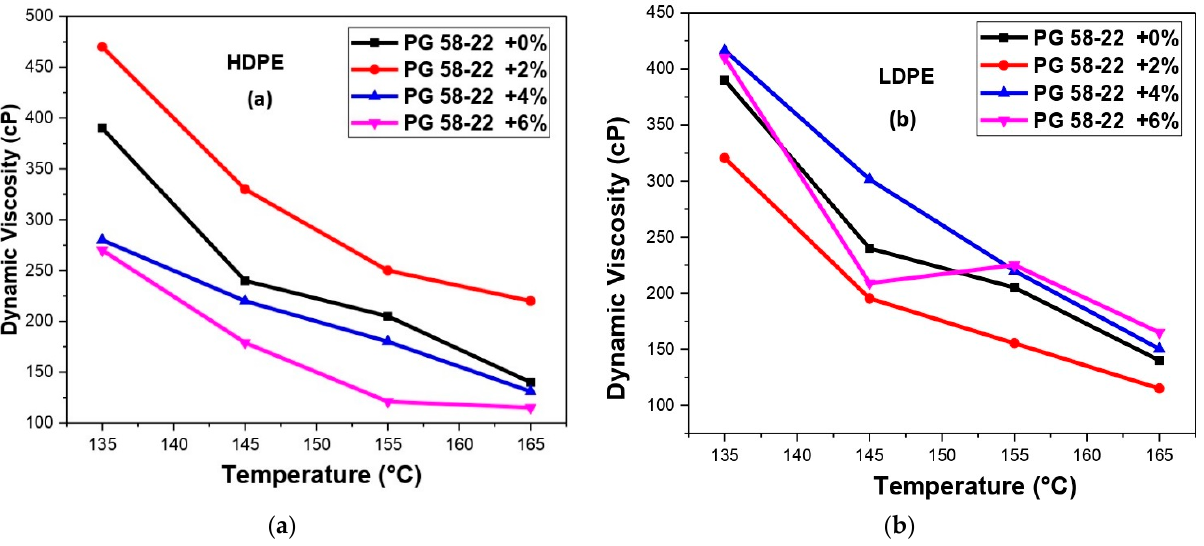
Figure 9. ( a ) The relation of dynamic viscosity with temperature for HDPE modified bitumen, ( b ) relation of dynamic viscosity with temperature for LDPE modified bitumen.